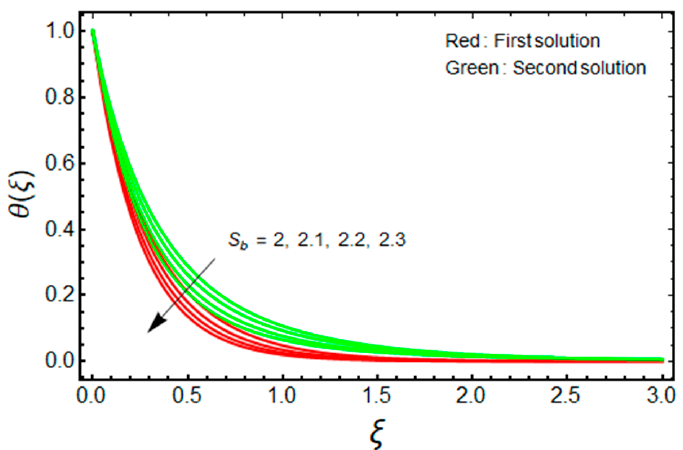
Figure 2. Effect of S b on G (cid:48) ( ξ ) when φ = 0.025, χ = 1, M b = 0.5.